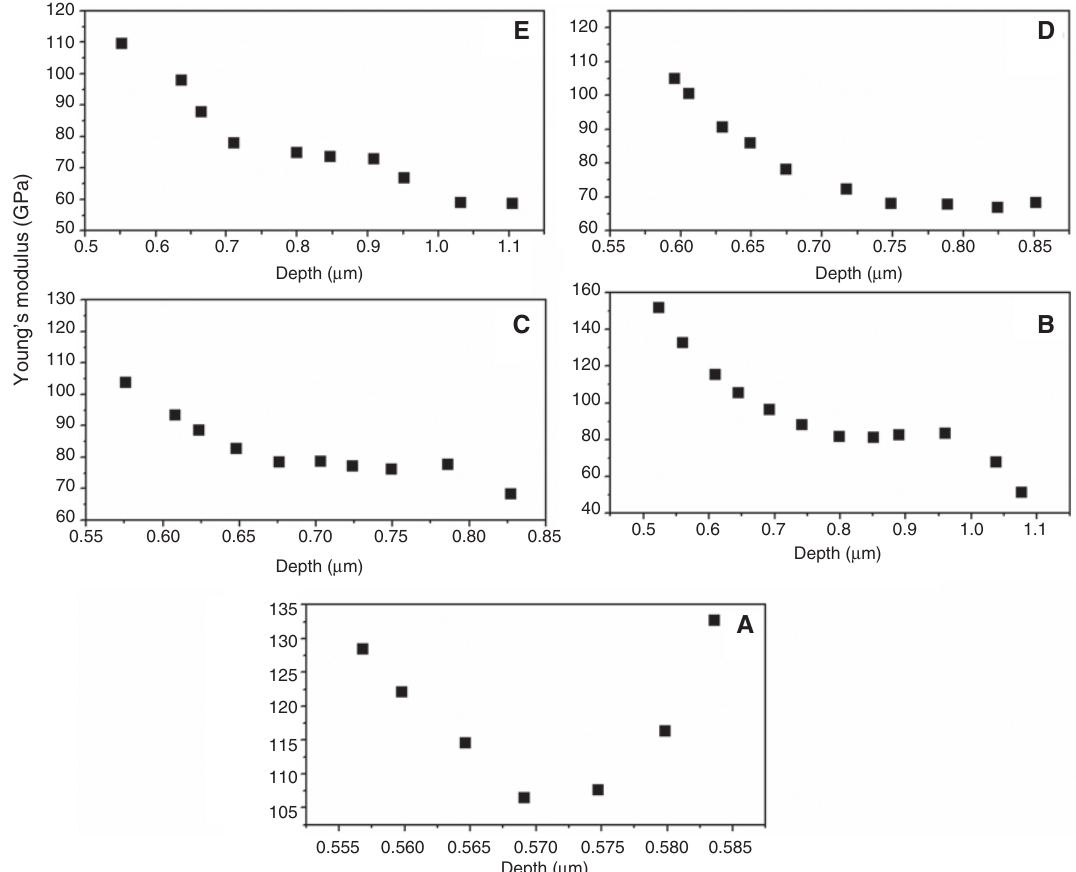
O nanocomposites for all five specimens taken from the half of the cylindrical 2 3